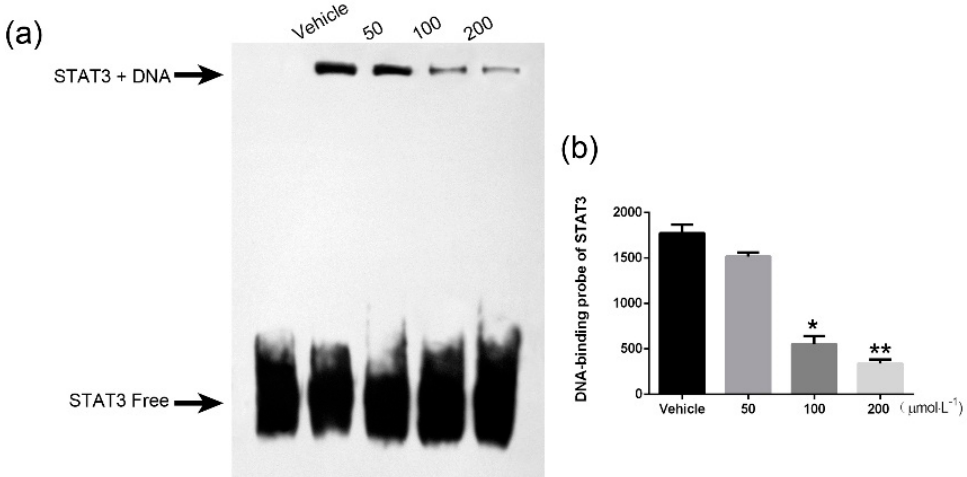
Figure 7. Effect of TTF1-NP on STAT3 DNA binding activity in HepG2 cells. ( a ) EMSA assays with HepG2 cells combined with TTF1-NP in 50, 100, 200 μ M; ( b ) Quantification of EMSA results using Image Quant software (Amersham). Data represent the mean ± SD of three measurements. * p < 0.05, ** p < 0.01 vs. Vehicle group.